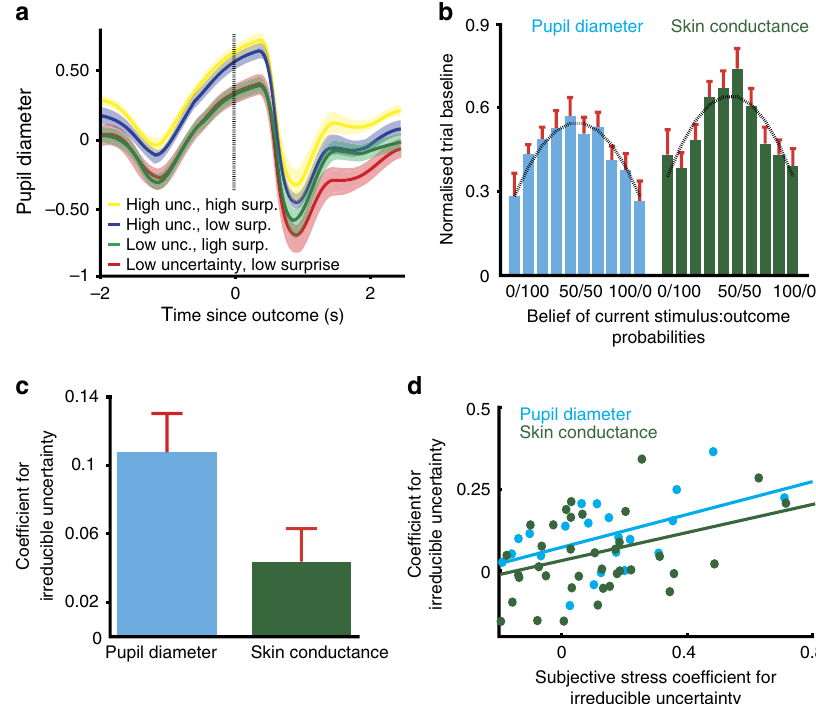
Figure 5 | Physiological responses reflect uncertainty and surprise. ( a ) Median splits indicate that both irreducible uncertainty and surprise increase pupil diameter (both P o 0.001). Shading is s.e.m. across participants. ( b ) Baseline pupil diameter and skin conductance on each trial displayed a clear inverted-U relationship with belief, as seen for subjective stress. A curve describing the variance of a Bernoulli distribution fit well (Pearson correlations: pupil diameter: r ¼ 0.96, P o 0.001; skin conductance: r ¼ 0.84, P ¼ 0.002). Error bars represent s.e.m. ( c ) A multiple regression model demonstrated a role for uncertainty throughout the trial for both pupil diameter (robust regression b ¼ 0.11, single-sample t -test, t 21 ¼ 4.72, P o 0.001) and skin conductance (robust regression b ¼ 0.044, single-sample t -test, t 36 ¼ 2.25, P ¼ 0.031). Error bars represent s.e.m. ( d ) Across subjects, the sensitivity of subjective stress to irreducible uncertainty correlated with the sensitivity observed in pupil diameter (Pearson correlation, n ¼ 22, r ¼ 0.52, P ¼ 0.013) and skin conductance (Pearson correlation, n ¼ 37, r ¼ 0.38, P ¼ 0.021) models. Each data point is one